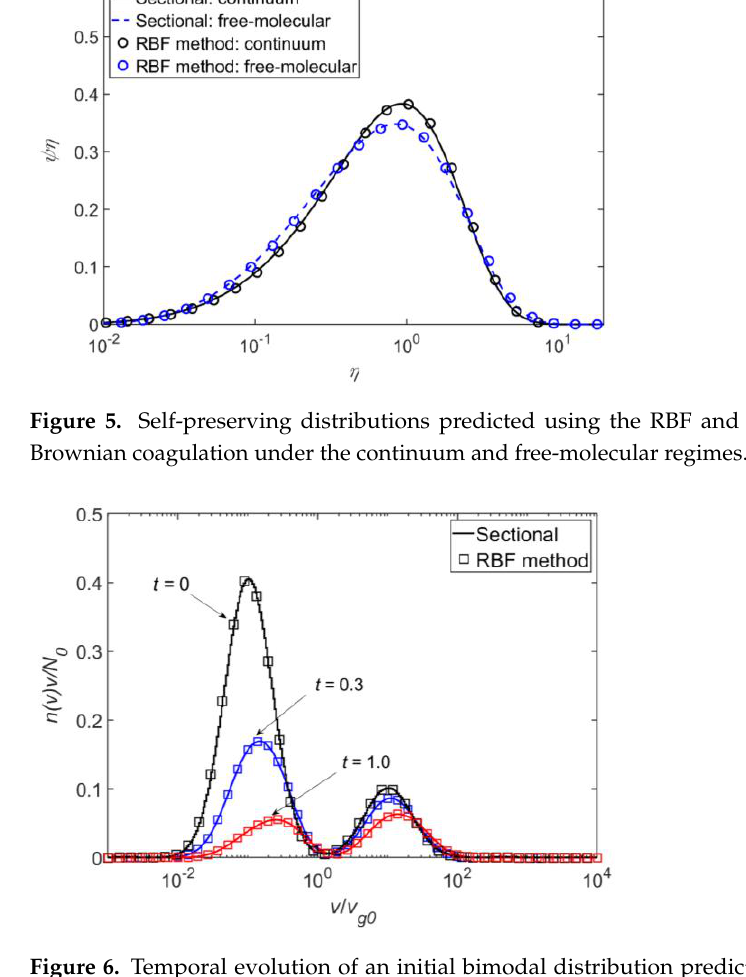
Figure 6. Temporal evolution of an initial bimodal distribution predicted using the RBF and the sectional methods for Brownian coagulation under the continuum regime.